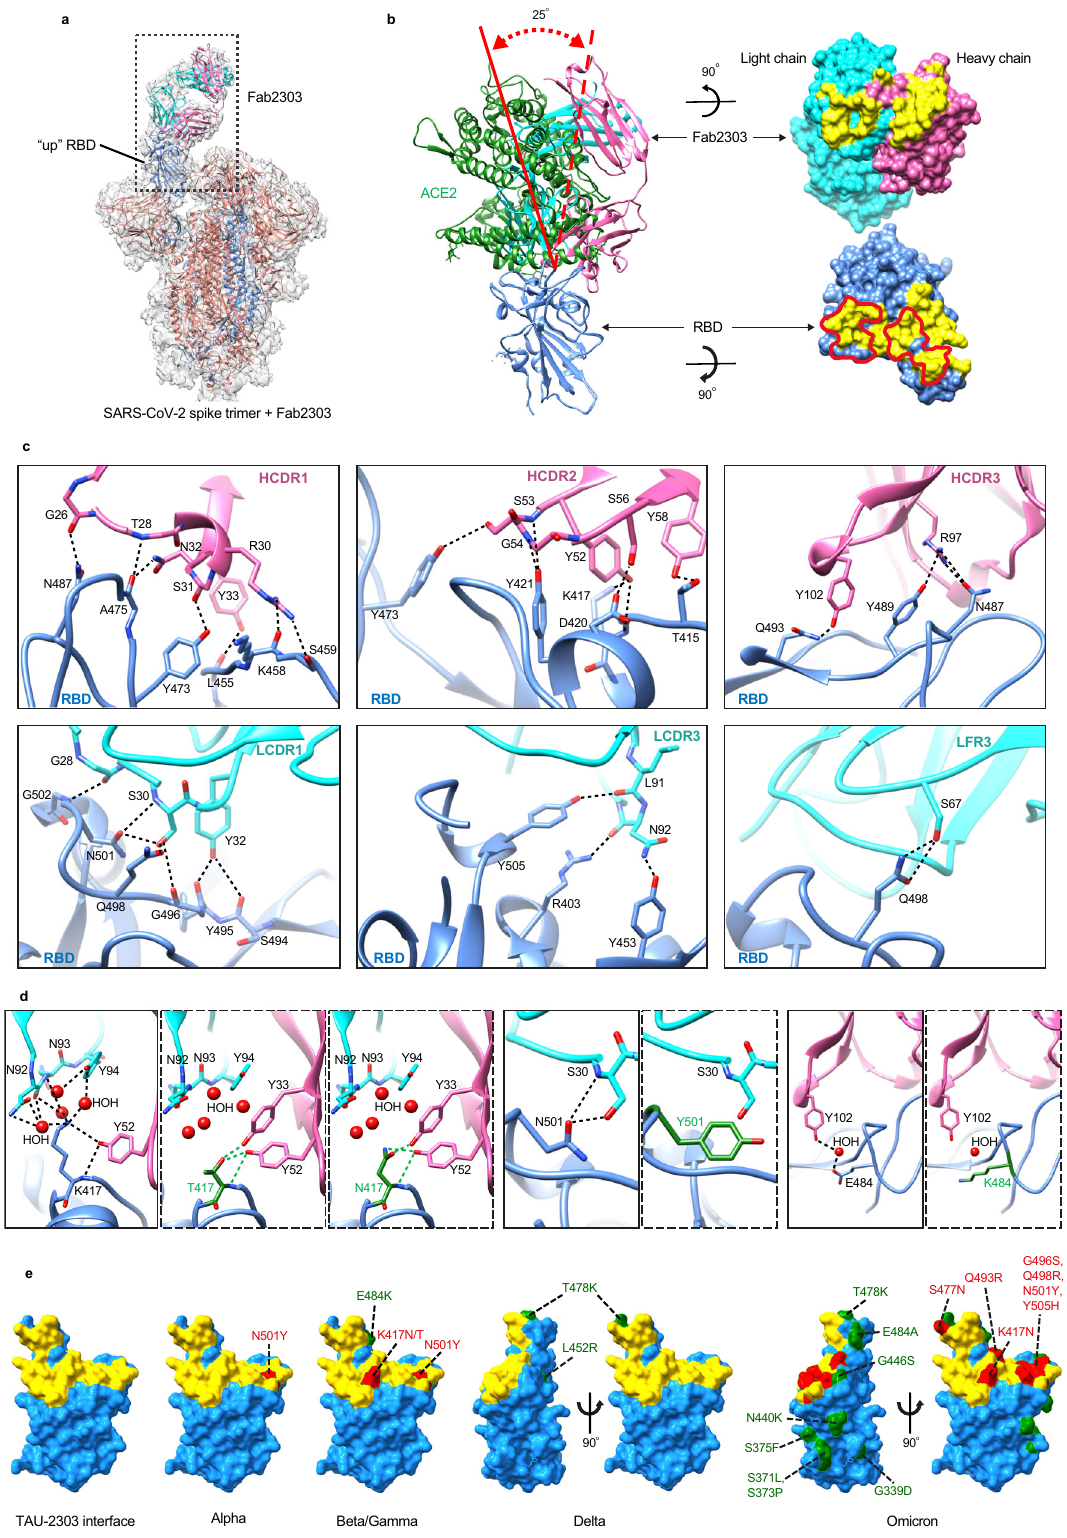
15868, 14193, 72056, and 39788 particles, respectively (Supple- mentary Fig. 6 and Table 2). In all fi ve conformations, only the Fab portion of mAb TAU-2212 is visible, while the highly fl exible Fc region is not seen in the reconstructed maps. Conformations 1, 3 and 4 are composed of two, three and three bound Fabs, respectively, with all the RBDs in the “ down ” position.